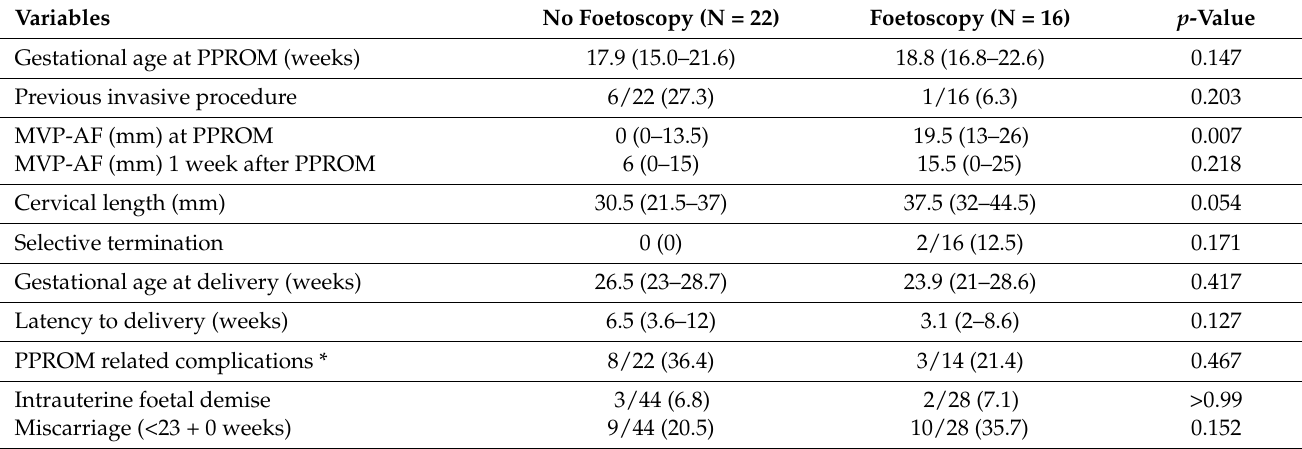
Table A1. Gestational and perinatal outcomes in foetoscopy versus no foetoscopy